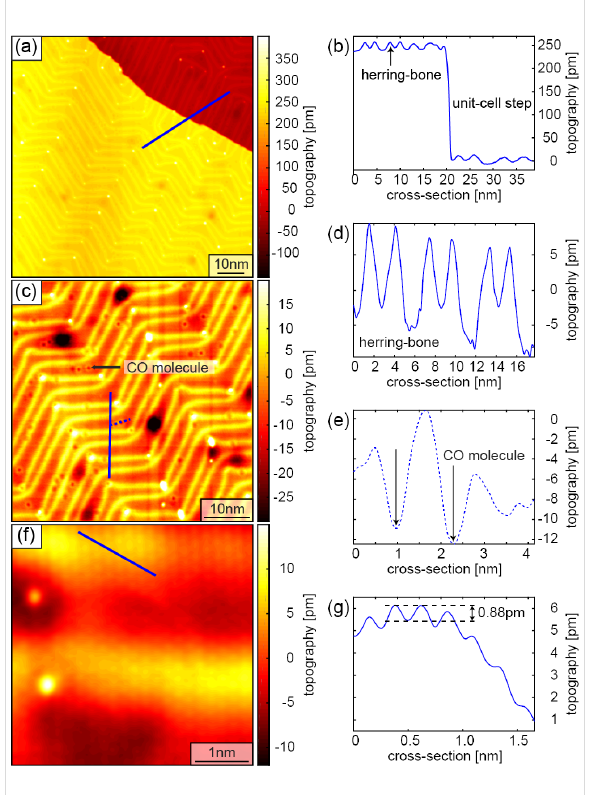
Figure 11: (a, c) STM results on Au(111) obtained at 600 mV and 20 pA. (b, d, e) Cross sections taken at the locations of the solid blue lines in panels (a) and (c) and the dashed blue line in panel (c). (f) Atomic-resolution image acquired at 5 mV and 30 pA. The cross section (g) taken at the location of the blue line in panel (f) shows an atomic corrugation of only 0.88 pm.